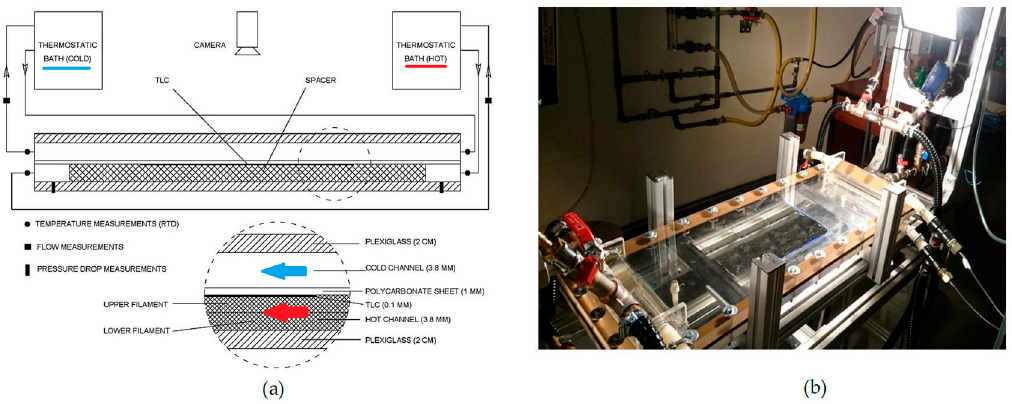
Figure 2. ( a ) Schematic representation and ( b ) picture of the experimental setup.